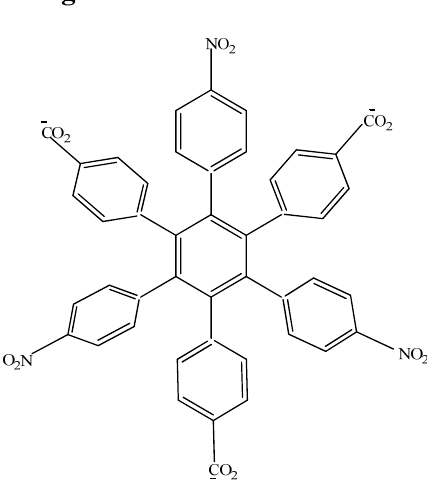
Figure 2. Structure of HAB1